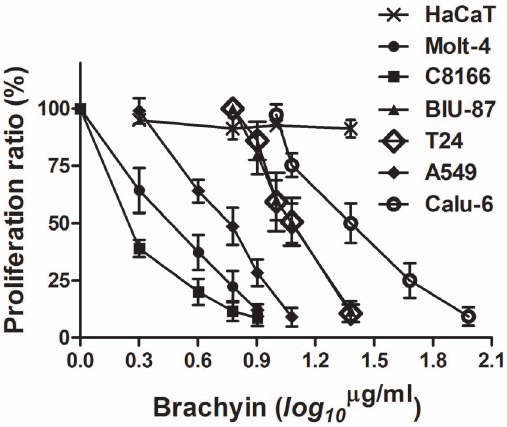
Figure 5. Cell proliferation inhibitory activity of brachyin. Human HaCaT keratinocyte cell, human T cell lines Molt-4 and C8166, bladder cancer cell lines BIU-87 and T24 and lung cancer cell lines A549 and Calu-6 were seeded into a microtiter plate and allowed